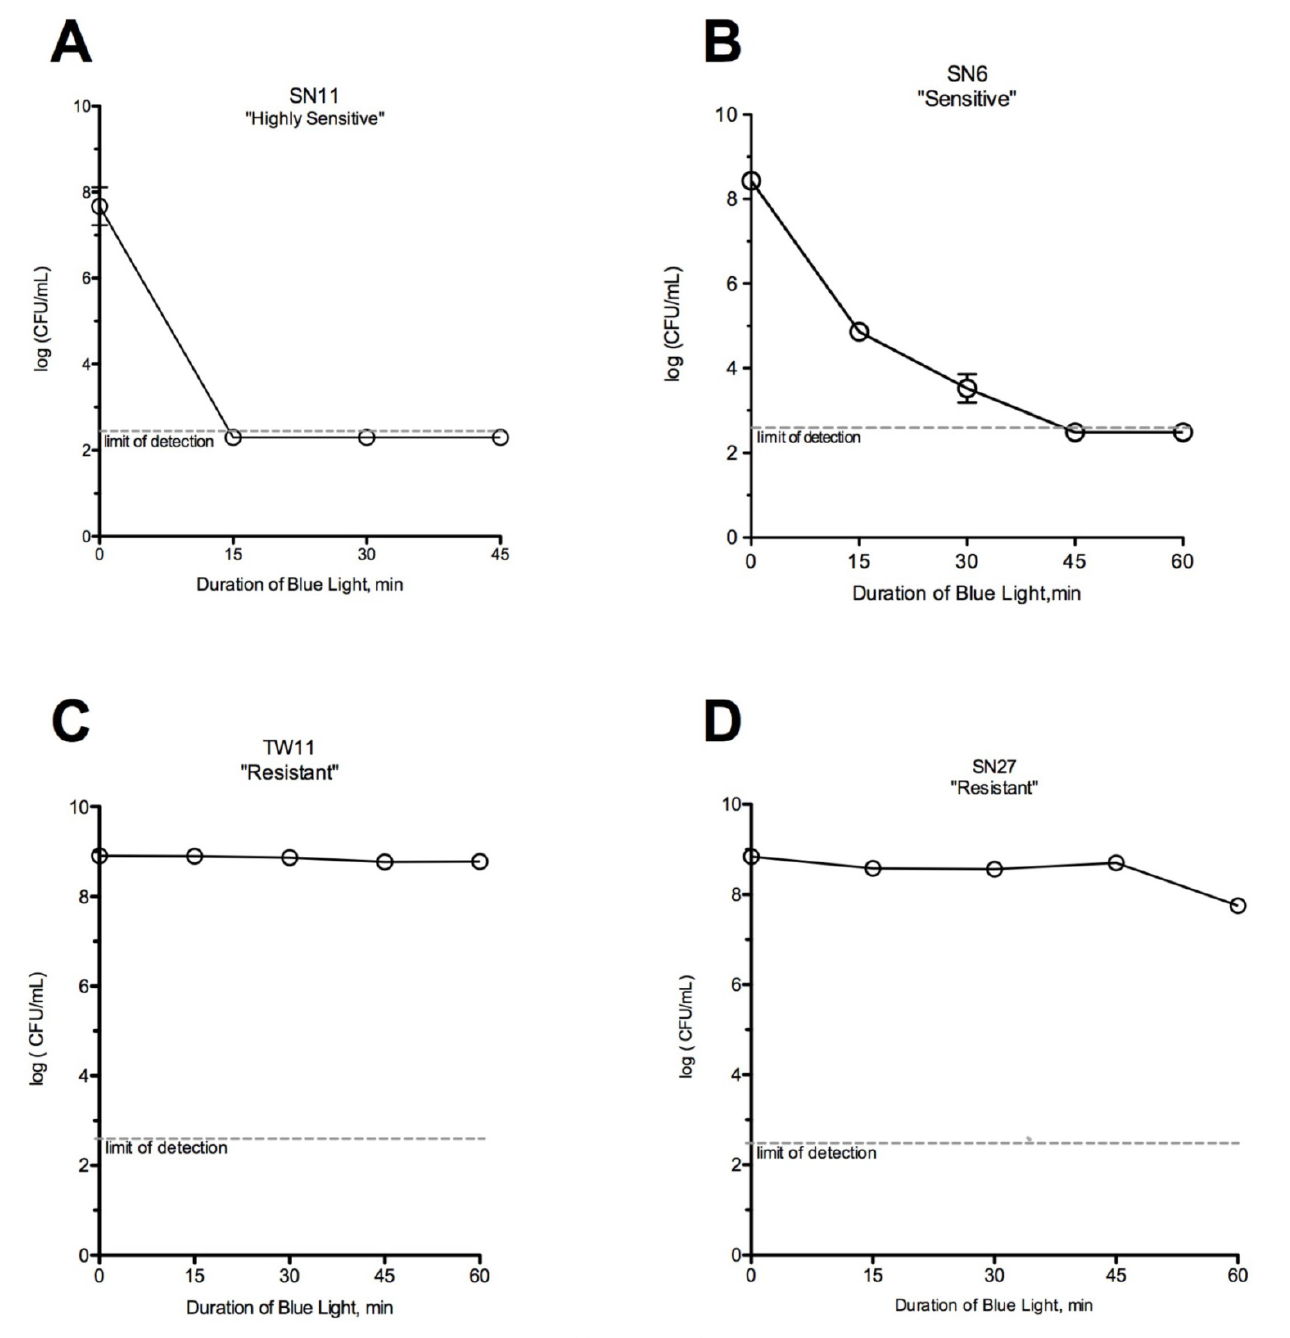
Figure 2. Susceptibility of C. acnes strains to blue light alone. (A) SN11 was killed by 15 minutes of exposure to blue light alone ( HS ). (B) Strain SN6 required a longer period of exposure to be killed by blue light alone ( S ). Strains (C) TW11 and (D) SN27 were not killed despite 60 minutes of blue light exposure ( R ).